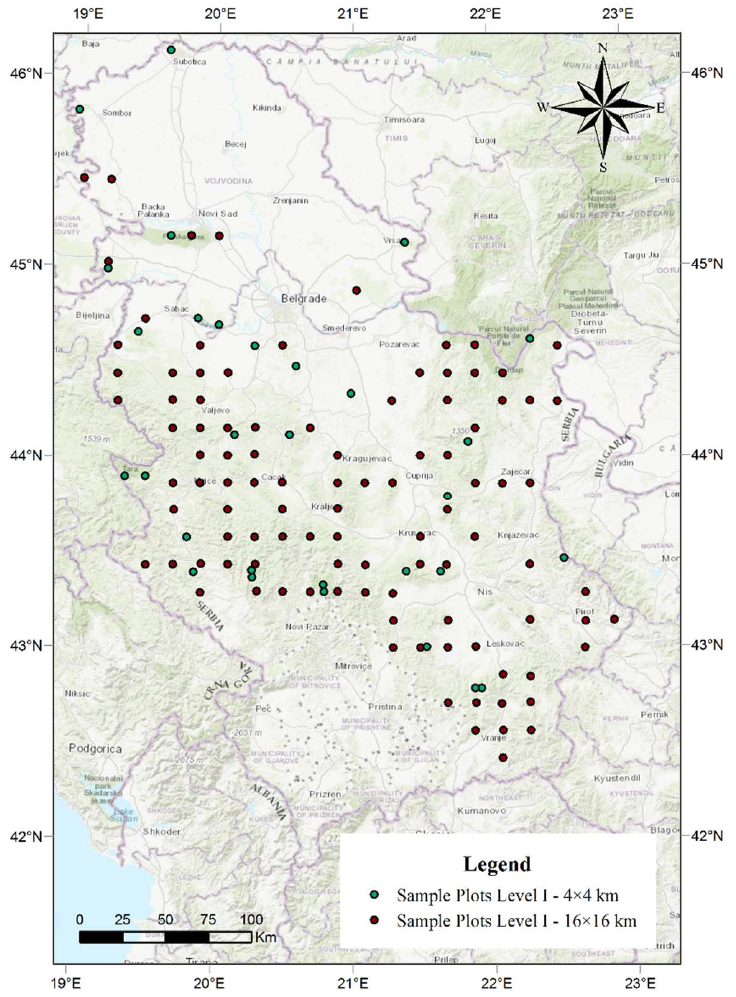
Figure 5. The spatial arrangement of sample plots in the territory of the Republic of